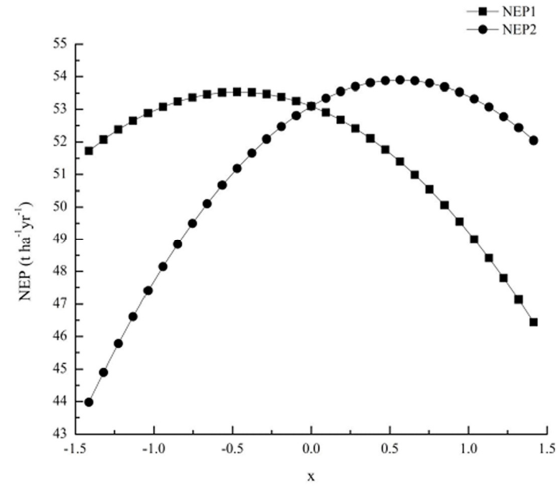
Figure 4. Single effect of selective thinning intensity or thinning residual removal rate on net ecosystem productivity (NEP). x is controlled factor selective thinning intensity or thinning residual removal rate. NEP1 and NEP 2 are effects of selective thinning intensity and thinning residual removal rate on NEP respectively.